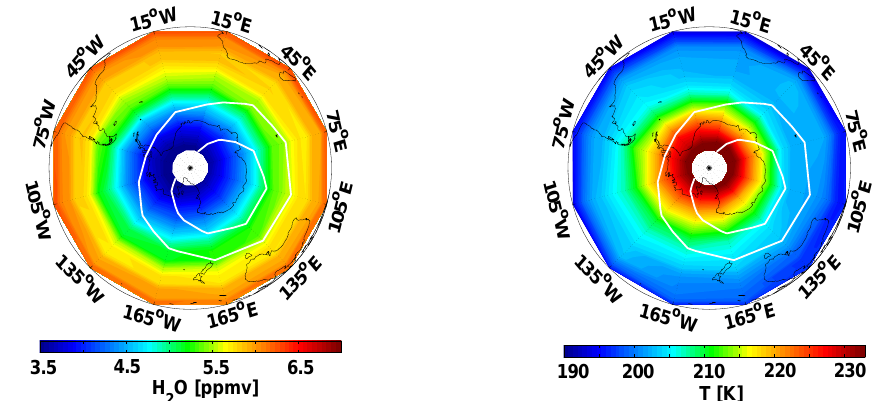
Fig. 5. Spatial distribution of nighttime H 2 O (left panel) and temperature (right panel) medians during low EEP period (case II) averaged between 70 and 76km. Median values were calculated for each 5 (latitude) × 30 (longitude) degree bins between latitudes 82 ◦ N to 82 ◦ S and longitudes 180 ◦ W to 180 ◦ E. Approximate geomagnetic latitudes 55–72 ◦ N/S are indicated by superimposed white